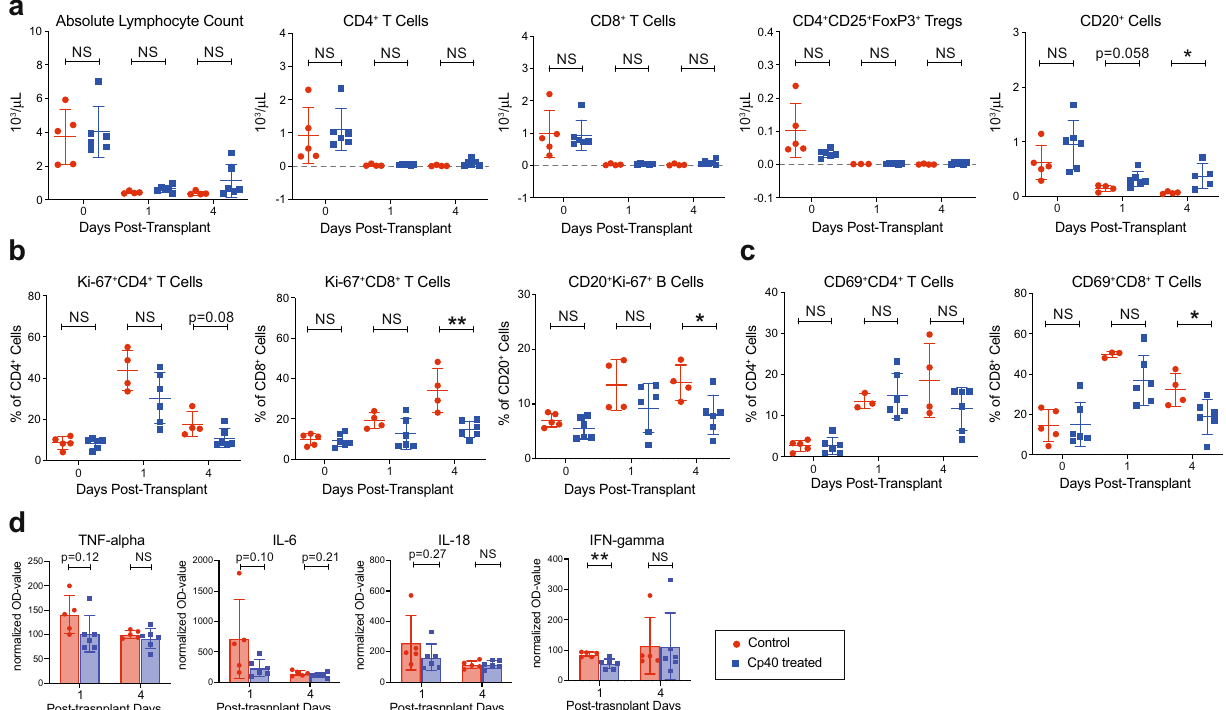
Fig. 2 Cp40 inhibits lymphocyte activation and proliferation. a Absolute count of lymphocytes, T cell, T cell subsets including CD4 + CD25 + FoxP3 + T regulatory cells, and B cells of the early post-transplant phase (day 0 – 4) of the control ( n = 5) and Cp40 group ( n = 6). At least n = 3 was analyzed per time point. b Post-transplant T and B cell proliferation in control ( n = 4 or 5) vs. Cp40 group ( n = 6). Frequency of proliferating CD4 + T cells, CD8 + T cells, and CD20 + B cells de fi ned through Ki-67 positivity. c Post-transplant T cell activation in control vs. Cp40 group. Frequency of activated CD4 + and CD8 + T cells de fi ned through CD69 positivity. d Relative changes of post-transplant in fl ammatory cytokines TNF- α , IL-6, IL-18, and IFN- γ from the control ( n = 5) and Cp40 group ( n = 6). All data are presented as mean ± S.D. N number indicates biologically independent animals; * p < 0.05; ** p < 0.01 using two-tailed parametric unpaired t test; NS indicates no statistical signi fi